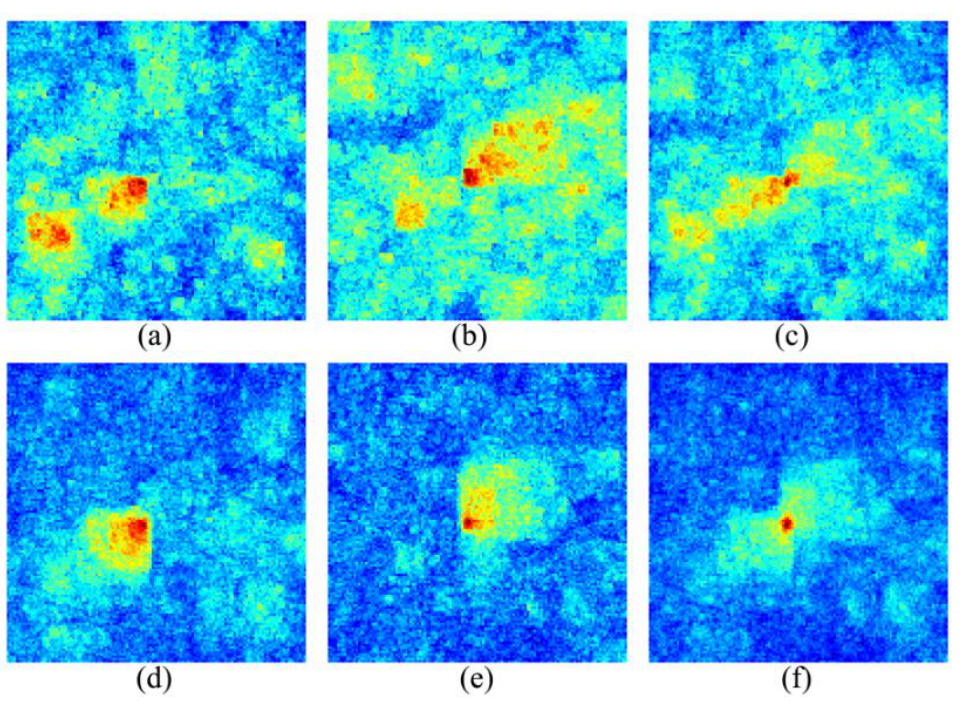
Figure 2. The distributions of different merit functions. ( a , d ) Distributions of merit functions with sequential accumulation at time t = 50; ( b , e ) distributions of merit functions with reverse accumulation at time t = 50; ( c , f ) distributions of averaged merit functions with sequential accumulation and reverse accumulation at time t = 50; ( a – c ) the calculation results of the algorithm proposed in Ref. [15]; ( d – f ) the calculation results of the MFF-DP algorithm; the size of simulation image is 128 × 128 pixels, the sequence length is N = 100, the background noise is 𝑛 𝒑(𝑡) ~𝑁(0,1) , the point target is SNR = 1.8, the initial position is (30, 20), and motion velocity is (0.6, 0.8) pixel/frame.